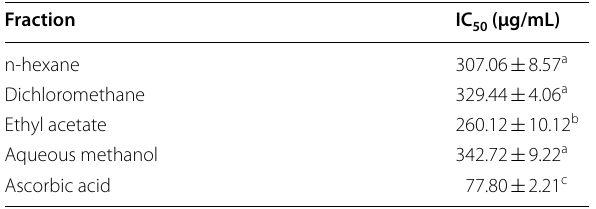
Table 7 IC values for DPPH scavenging activity of fractions 50 from leaf extract of C. albidum